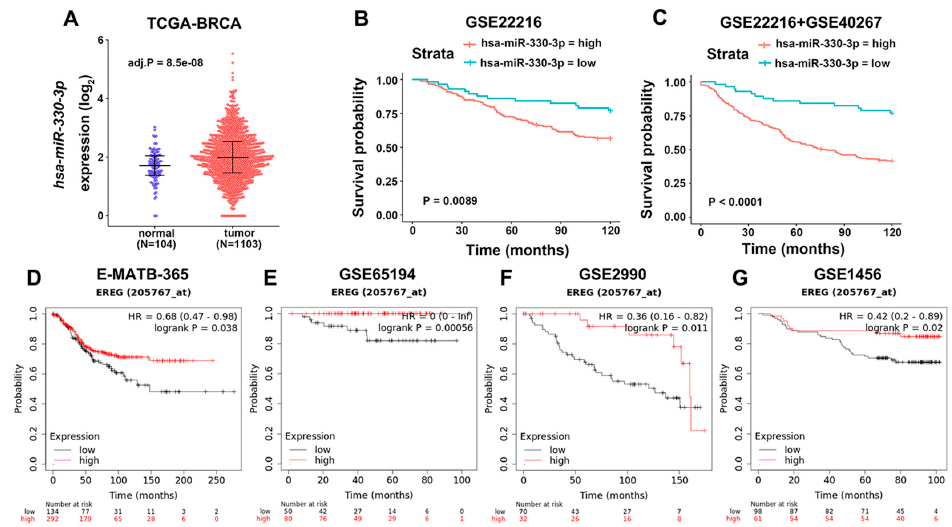
Figure 1. Evaluation of the roles of miR-330-3p and EREG in BC. ( A ) The expression level of miR-330-3p in BC specimens from the TCGA-BRCA dataset. ( B , C ) The expression level of miR-330-3p was associated with a poor clinical outcome from the GSE22216 and GSE40267 datasets. ( D – G ) EREG expression was negatively correlated with the clinical outcome of BC patients through analyzing the E-MATB-365, GSE65197, GSE2990, and GSE1456 datasets with the KMplot web tool.